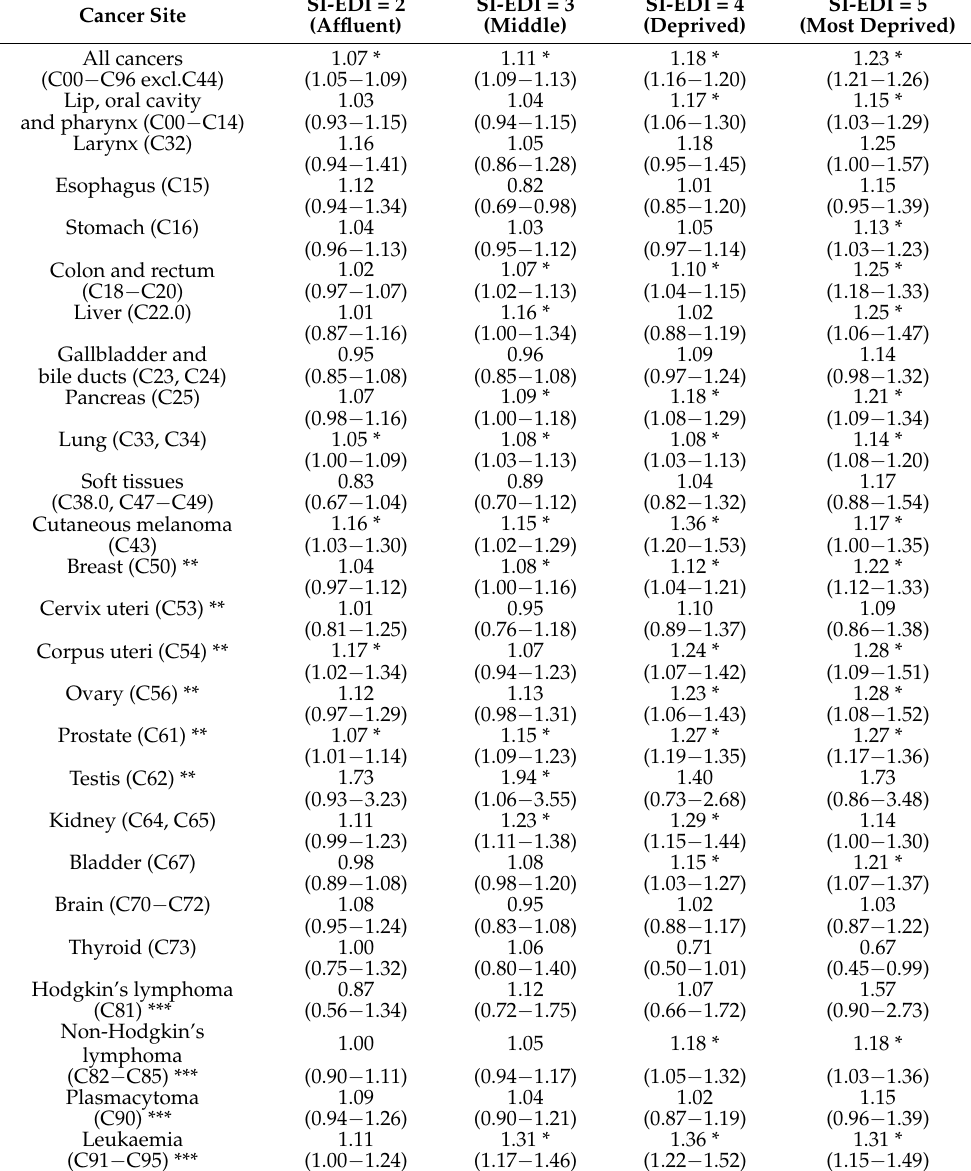
Table 2. Hazard ratios with 95% confidence intervals by cancer site according to ICD-10 classification and by Slovenian deprivation index (SI-EDI), for both genders combined, Slovenia 2004 − 2018. Hazard ratios are adjusted for gender, age group, stage, and calendar period. The reference category is most affluent cancer patients (SI-EDI =